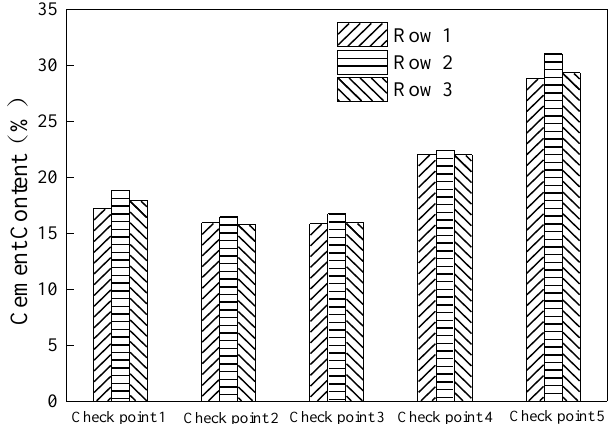
Figure 7. Verification chart of the cement contents of sampling cores in different rows.